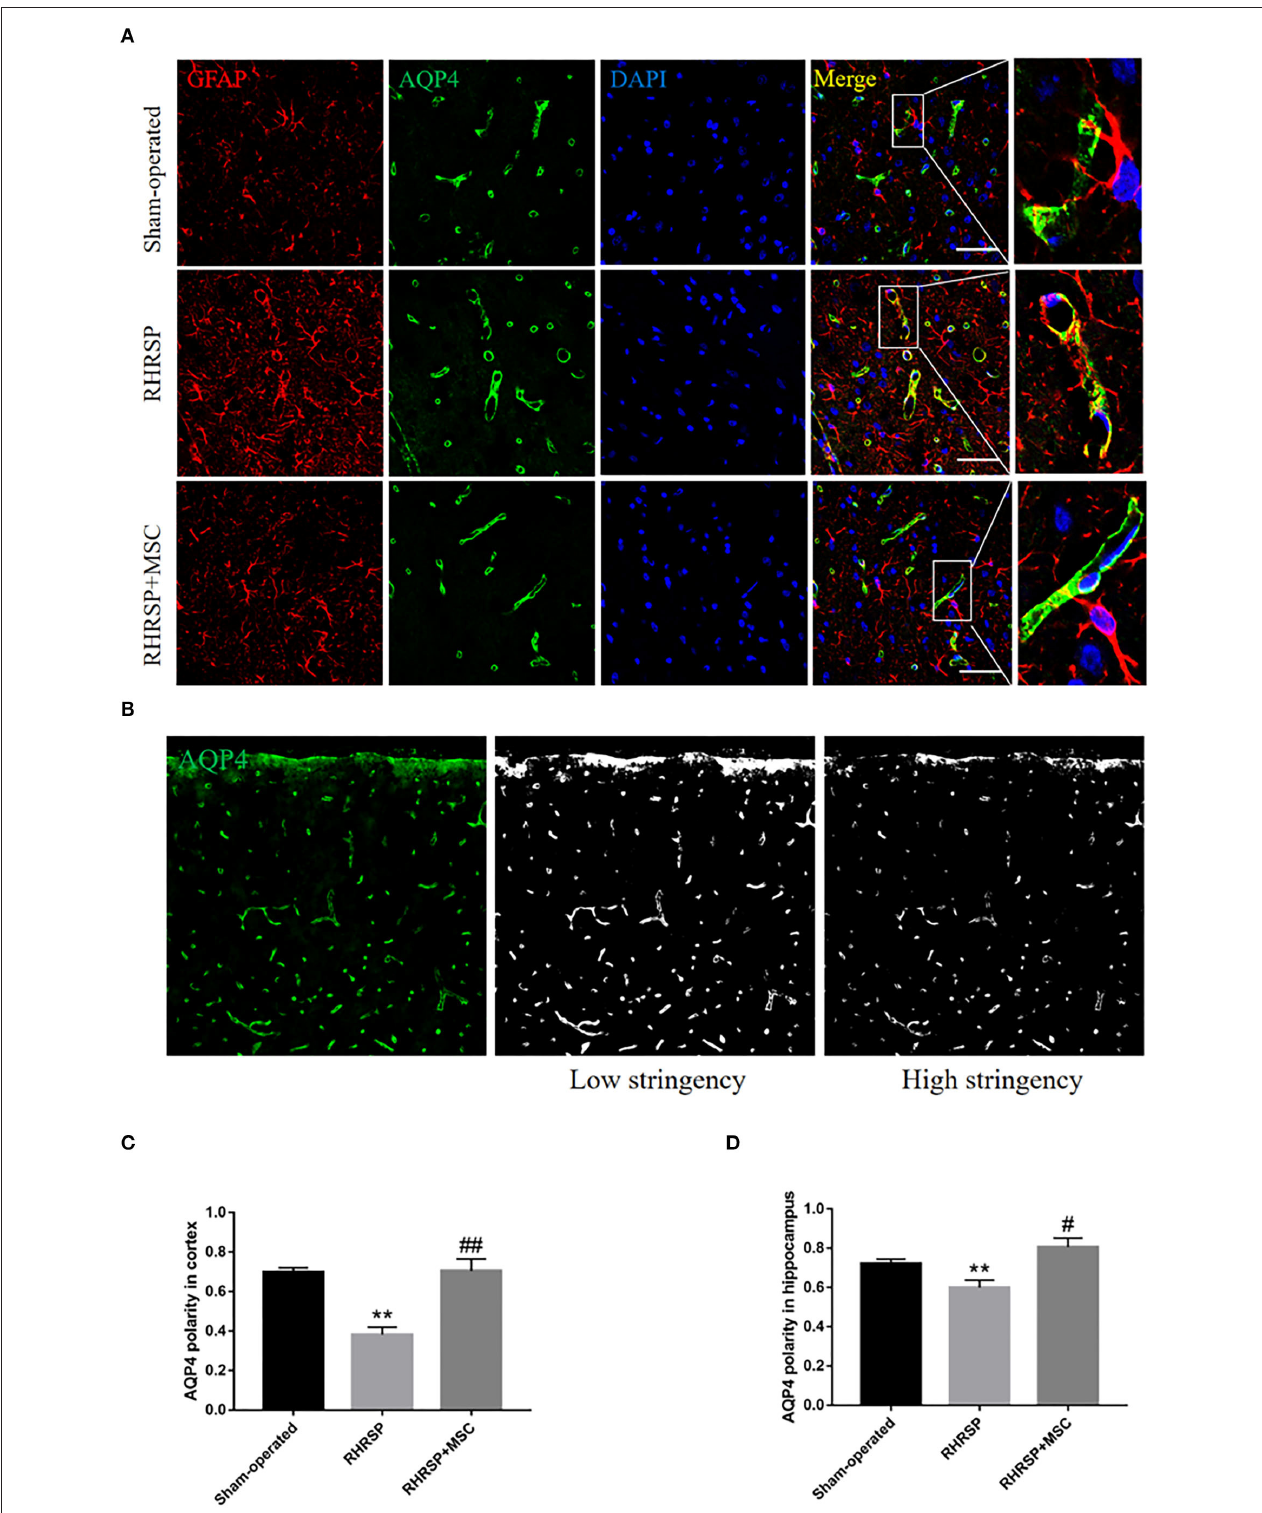
FIGURE 6 | Effects of MSCs on AQP4 polarity. (A) Representative images of AQP4 polarity in three groups. (B) The sample images of low-stringency and high-stringency of AQP4, thus received the “AQP4 polarity”, which is the ratio of the mean intensity of low-stringency to high-stringency. (C,D) Quantification of the AQP4 polarity in the cortex and hippocampus (** P < 0.01, vs. sham-operated group, # P < 0.05, ##P < 0.01, vs. RHRSP group; n = 6/group). scale bar = 25 µ m.